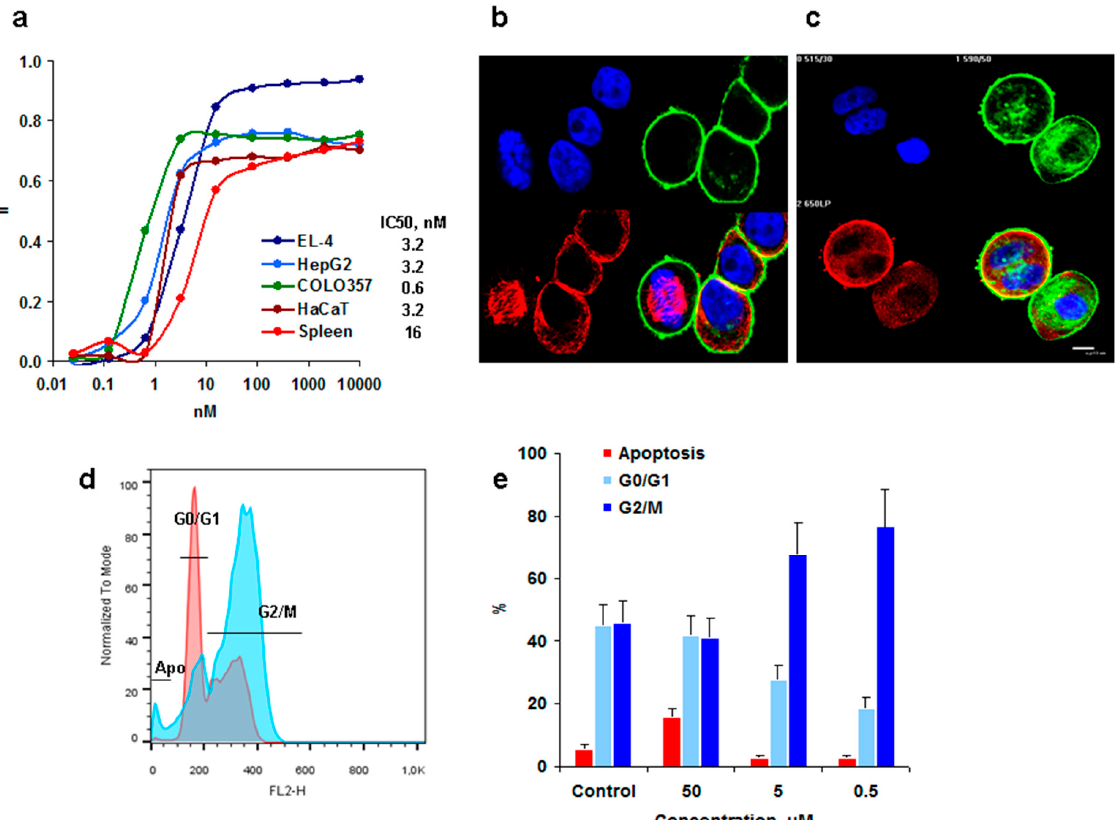
Figure 2. Functional characteristics of 9E : ( a ) Antiproliferative activity of 9E against EL-4, HepG2, COLO357 and HaCaT cell lines and against normal mitogen activated splenocytes (spleen); the IC 50 of the corresponding cells is shown on the right side. SD were around 5–15%, and are not shown for a better visualization. ( b , с ) Confocal microscopy analysis of β -tubulin (red) and F-actin (green) staining of K562 cells without ( b ) and with 500 nM of 9E . ( c ) Nuclei are stained with Hoechst 33342 (blue). Scale bar 15 µm. ( d , e ) Cell cycle analysis of K562 cells in control (( d ), pink histogram) and after 48 h incubation with 500 nM of 9E (( d ), blue histogram) and dose-dependent distribution of cell cycle phases. G2/M—cells with doubled DNA; G0/G1—nonproliferating cells with single DNA; Apo—apoptotic cells.